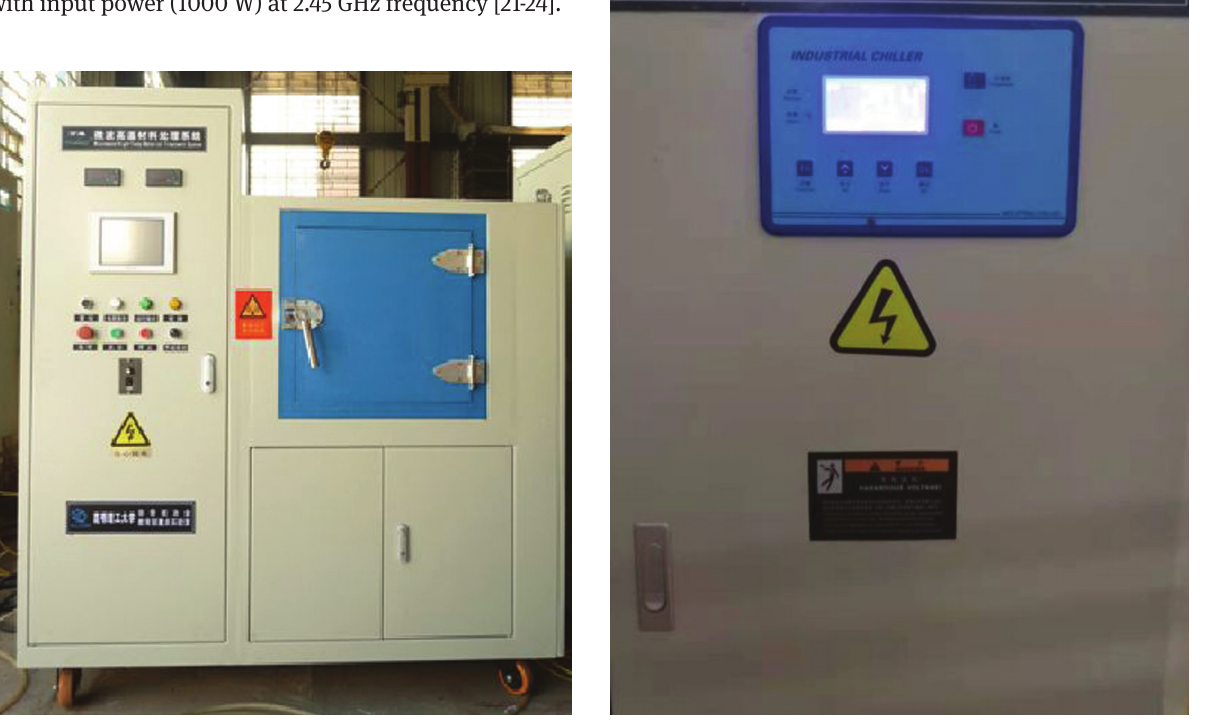
Figure 3: The temperature measuring device. Figure 2: The apparatus of microwave